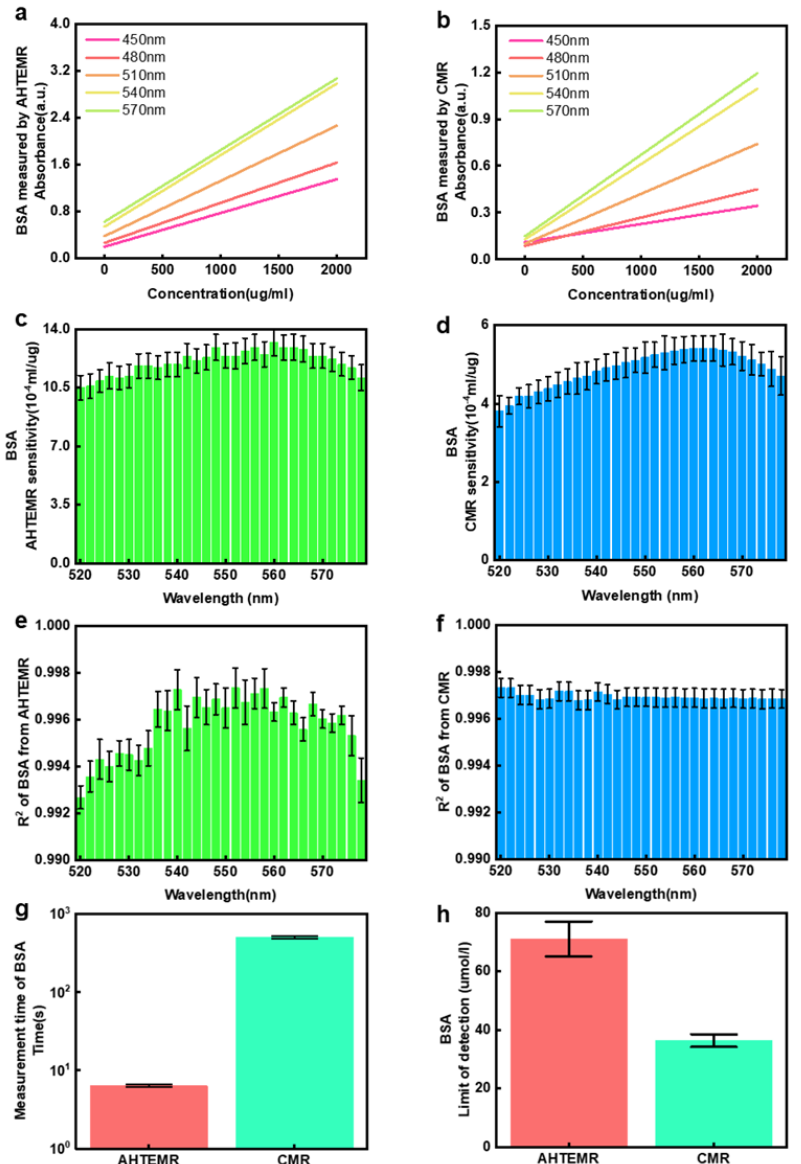
Figure 5. BSA spectral measurement using the AHTEMR and CMR: ( a ) Absorbance spectrum linear fitting results of BSA at different wavelengths measured by the AHTEMR. ( b ) Absorbance spectrum linear fitting results of BSA at different wavelengths measured by the CMR. ( c ) Sensitivity distribution of linear fitting results between 520 and 580 nm measured by the AHTEMR. ( d ) Sensitivity distribution of linear fitting results between 520 and 580 nm measured by the CMR. ( e ) R 2 distribution of linear fitting results between 520 and 580 nm measured by the AHTEMR. ( f ) R 2 distribution of linear fitting results between 520 and 580 nm measured by the CMR. ( g ) AHTEMR and CMR measurements of the time spent on the spectral measurement of BSA solution per well. Among them, the AHTEMR costs about 6.37 s per well and the CMR costs about 504.29 s per well. ( h ) Detection limits of the AHTEMR platform and CMR for BSA measurement by 3δ calculation ; the detection limit of the AHTEMR is 71.08 μg /mL, and the detection limit of the CMR is 36.34 μg /mL. All experiments were repeated in 3 well with error bars of mean ± SD.